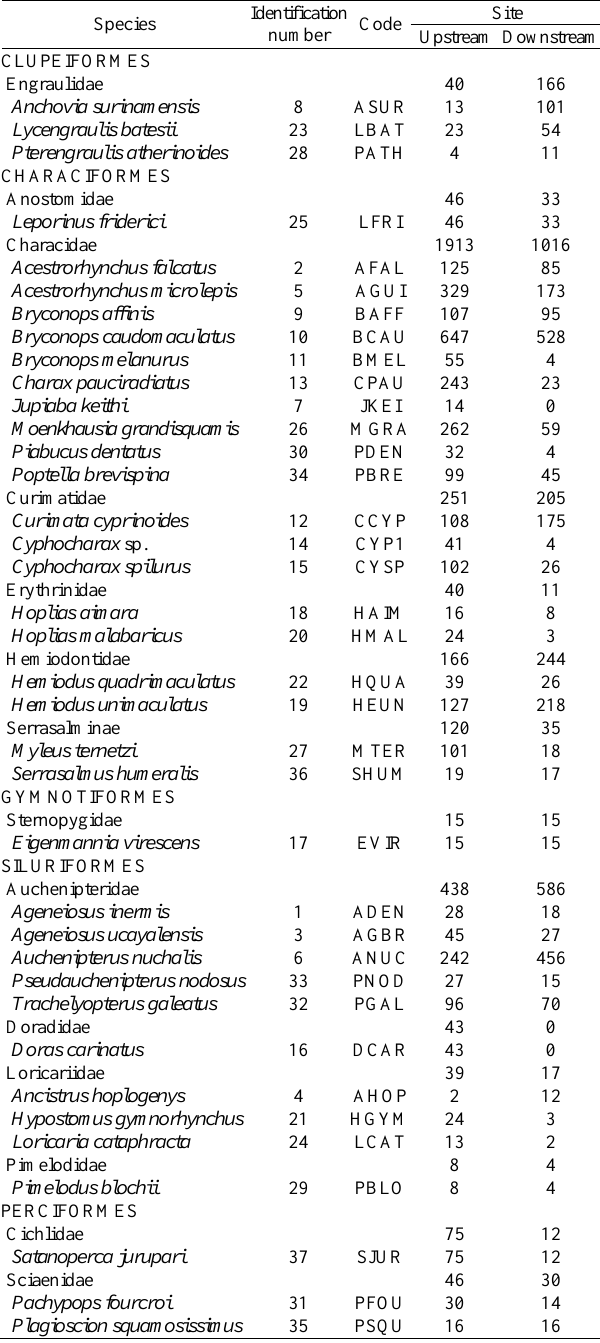
Table 1. Fish species with their respective identification number, code and number of individuals by site collected between August 1998 and July 2000 in the Comté River, French